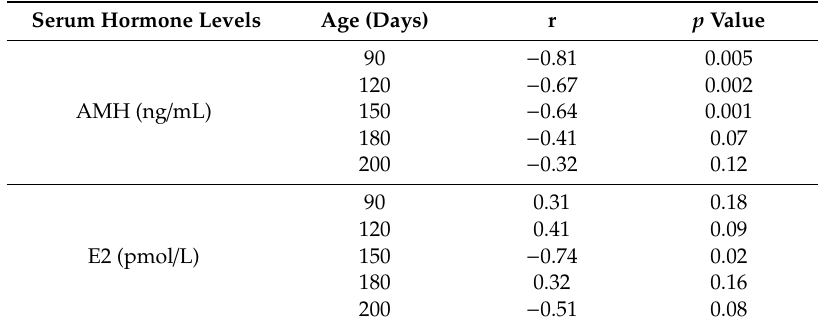
Table 2. Correlations between the age at puberty onset and hormone serum levels at 90, 120, 150, 180, and 200 days of age ( n = 60).